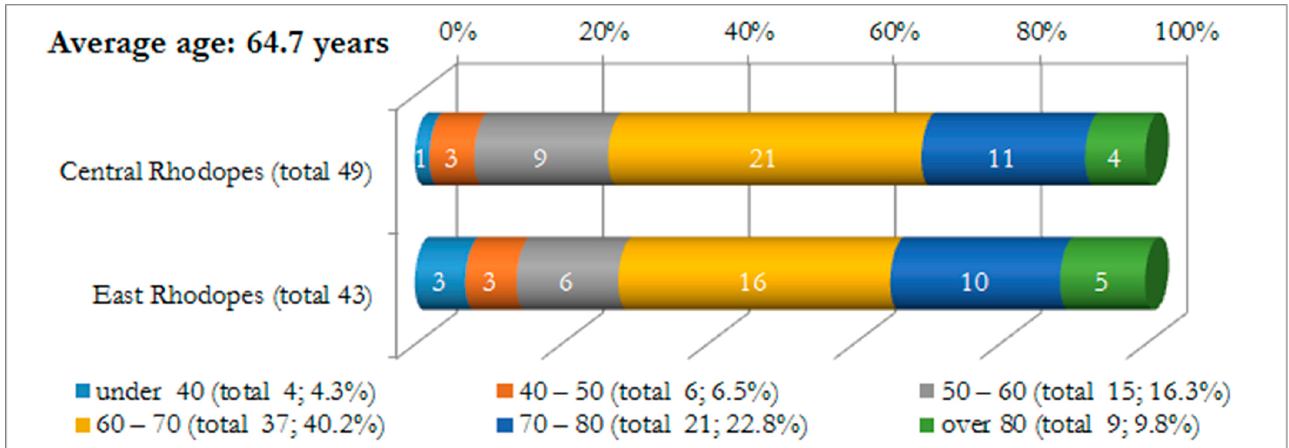
Figure 2. Demographic characteristics of informants by region and age.